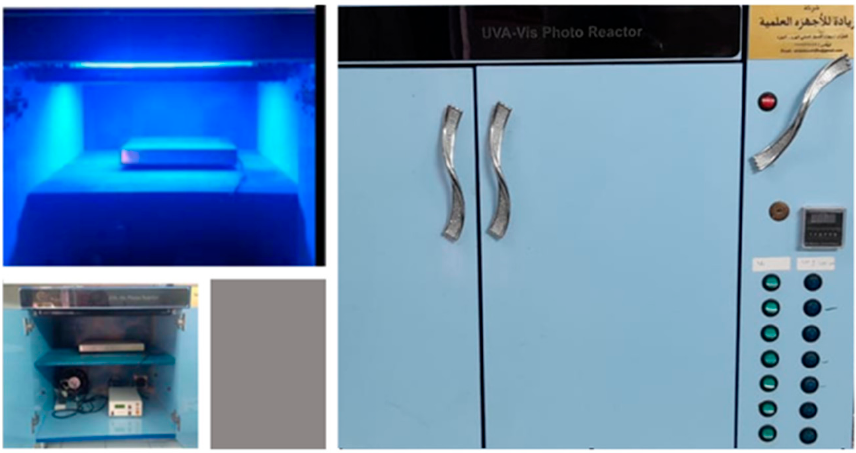
Figure 1. Photoreactor design and operation in NLEBA, Ain Shams University, Cairo, Egypt. A 100 mg of Nd 2 O 3 doped CuO NPS was inserted in 50 mL of MB solution. Agitation